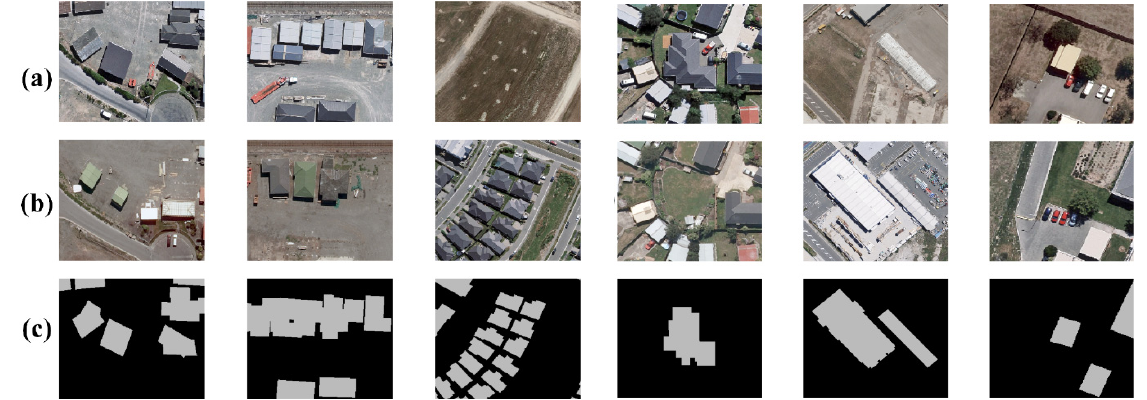
Figure 4. The representative building changes of every type in WHU Building Change Detection Dataset. ( a ) Before; ( b ) After; ( c ) Ground Truth.